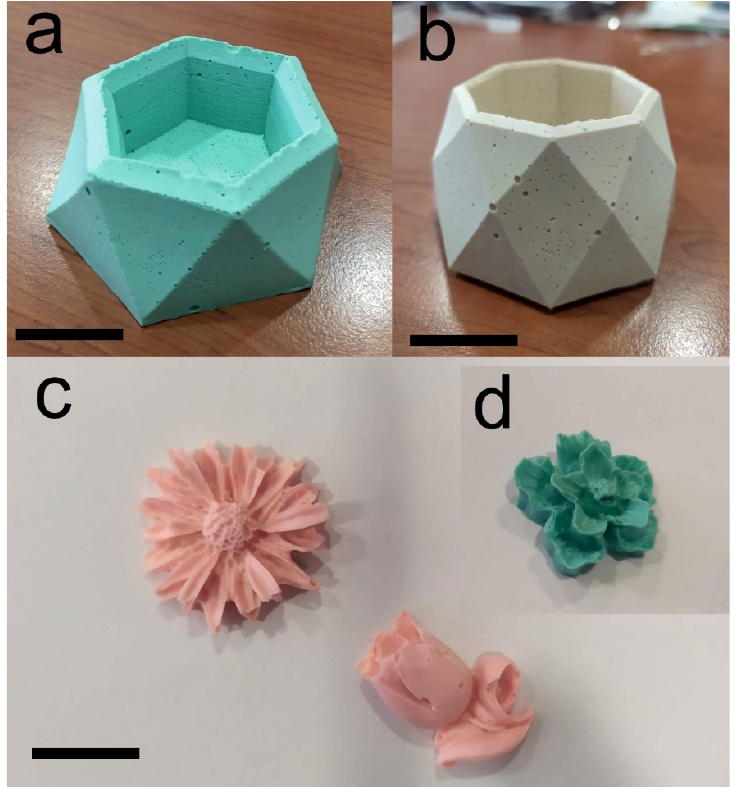
Figure 10. Examples of painted artefacts created with the geopolymer composite materials and presented in this paper. The artistic products were created by adding pigments to geopolymer paste and a simple pouring procedure. In ( a , b ) the scale bar is 4 cm, while in ( c , d ) the scale bar is 2 cm.